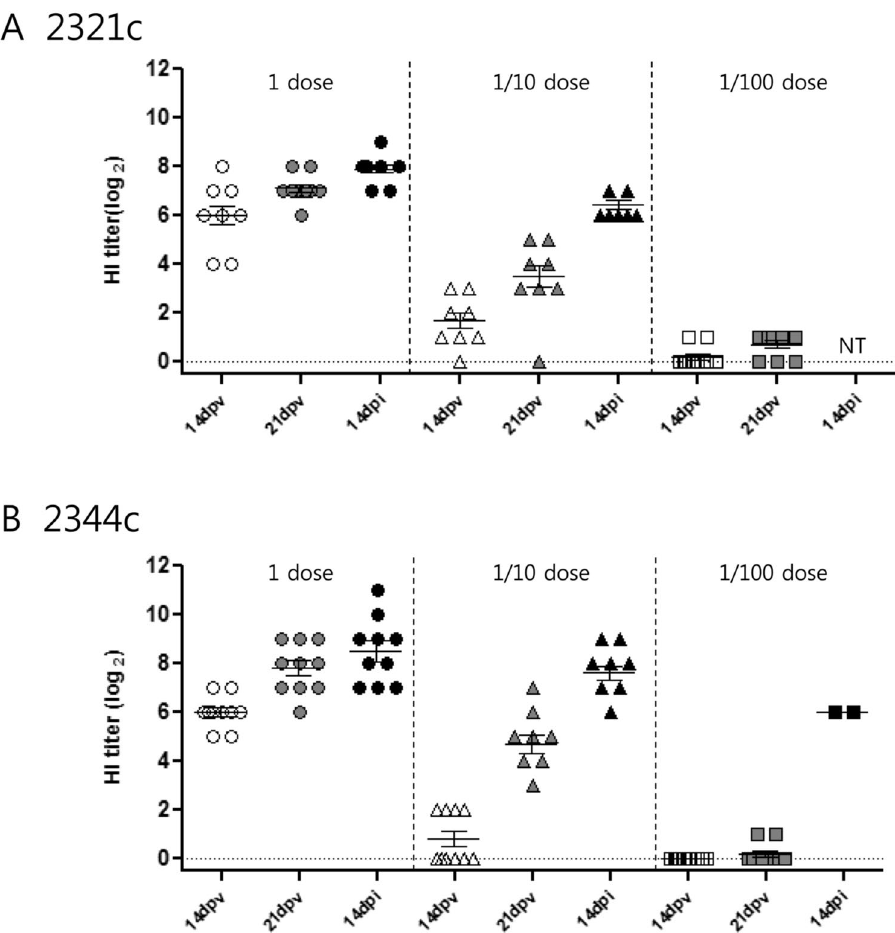
Figure 3. Serological responses in vaccinated and challenged chickens. Hemagglutination inhibition (HI) assay titers in vaccinated chickens measured at different times post-vaccination and challenged with homologous virus. HI titers were assessed at 14 days post-vaccination (dpv), at 21 dpv, and at 14 days post-infection (dpi) with homologous virus. Chickens received one (1) dose, one-tenth (1/10) dose, or one-hundredth (1/100) dose. ( A ) Challenge with KA435/2.3.2.1c. ( B ) Challenge with ES2/2.3.4.4c. Individual data points are shown, along with mean and standard